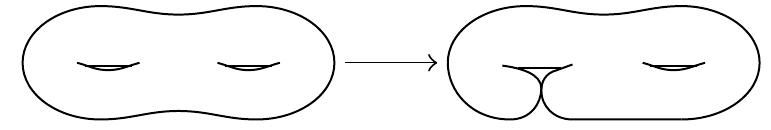
X 0 between two CY 3-folds. The red lines ! 1 curves in (respectively) X and X 0 . (cid:0)